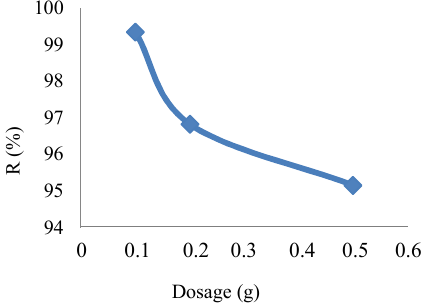
Fig. 4. Removal rate of Cu +2 at variable dosages